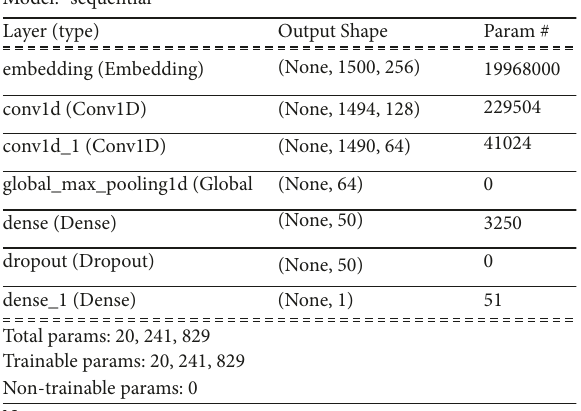
Figure 2: Seven-layer neural network model.